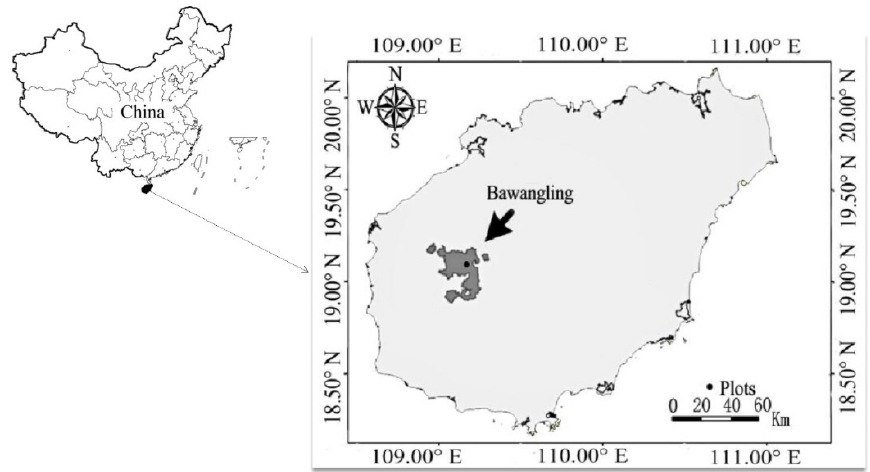
Figure 1. Location map of the study area.